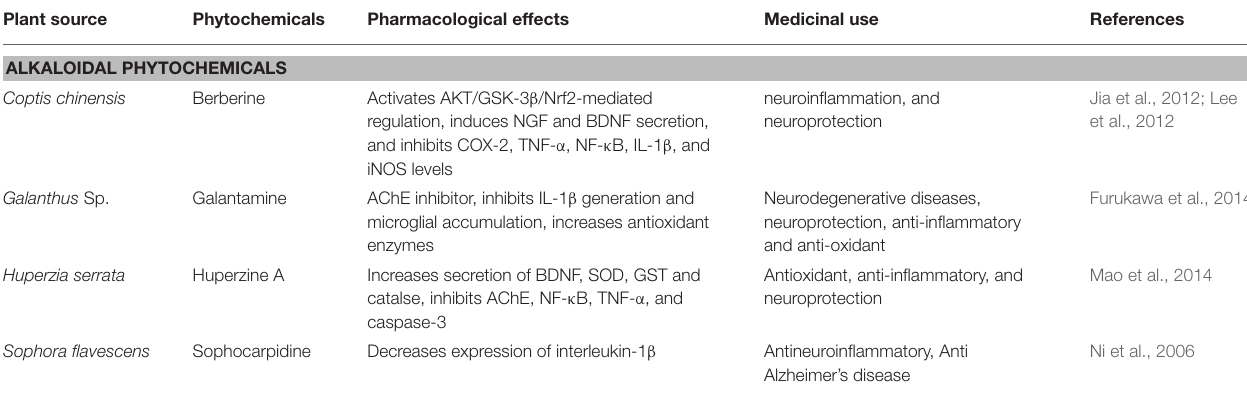
TABLE 4 | Alkaloidal phytochemicals that affect Alzheimer’s disease. Plant